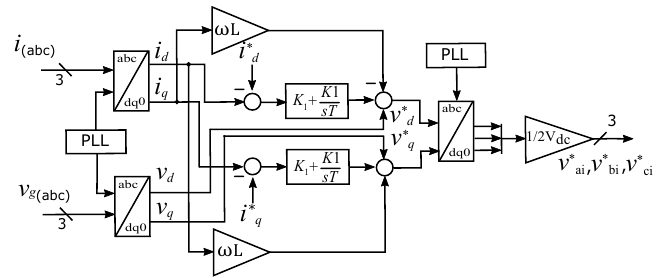
Figure 8. Current control implementation in the